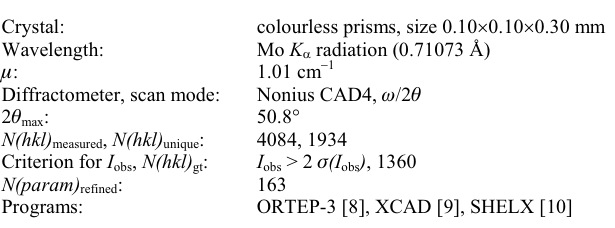
Table 1. Data collection and handling.